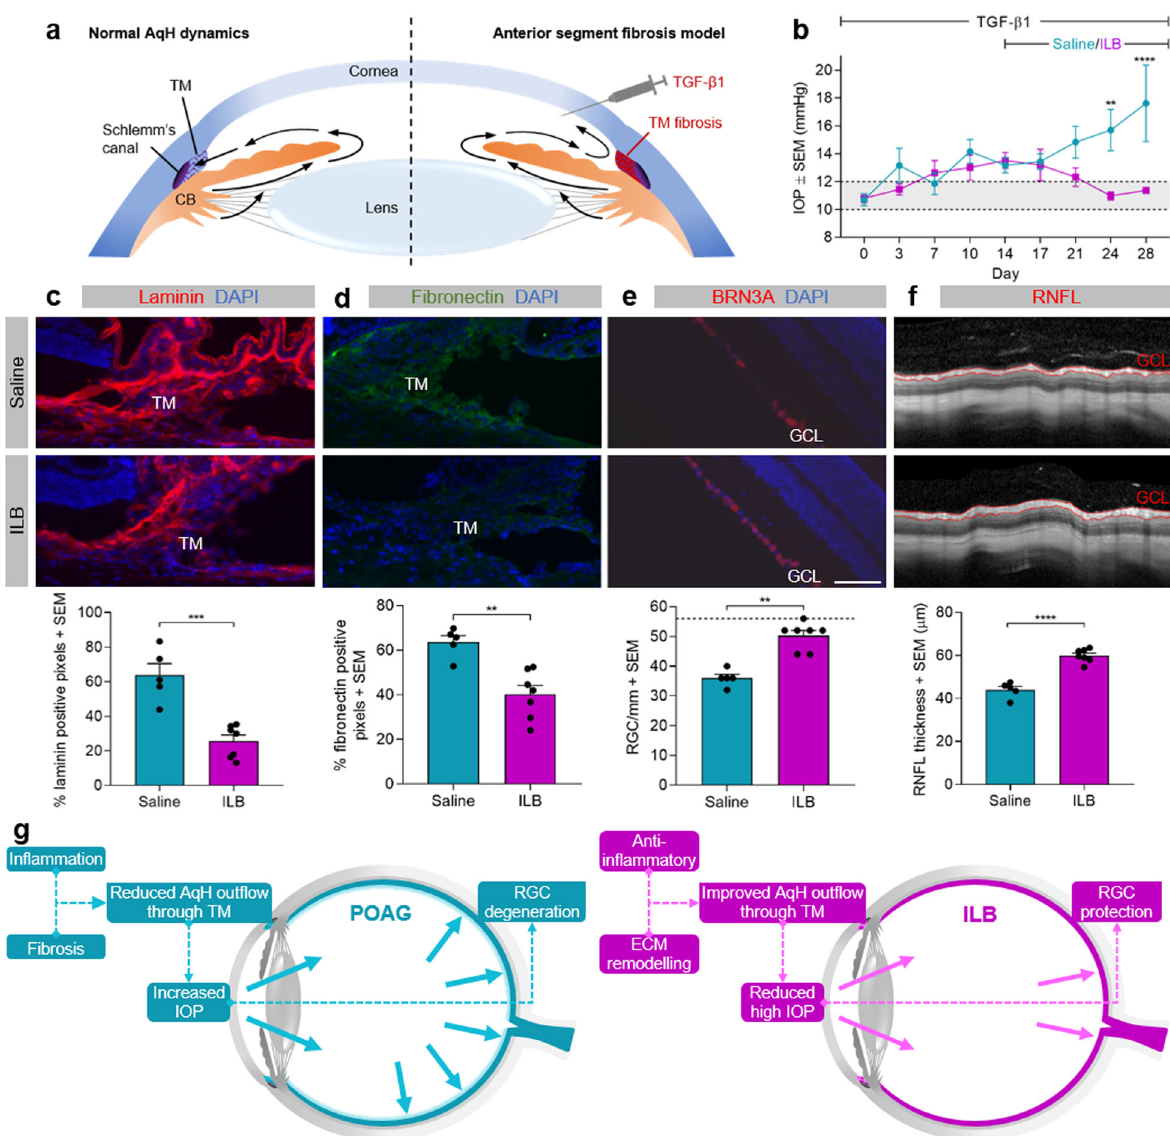
injections of TGF β 1 induced fi brosis in the trabecular meshwork (TM), blocking AqH out fl ow and raising IOP. ( b ) Line graph showing IOP measurements during IC TGF β 1 treatment for the fi rst 14 days followed by IC TGF β 1 with daily subcutaneous saline vehicle control or ILB ® treatment for a further 14 days. Normal IOP levels are indicated by the grey shaded area, ** P < 0.01, **** P < 0.0001 (2-way ANOVA). ( c , d ) Representative images of ocular tissue sections including the angle of the anterior segment together with related histograms showing levels of immunoreactive laminin (red) and fi bronectin (green) staining in the TM in the saline and ILB ® treatment groups, ** P < 0.01 *** P < 0.001 (t- test). ( e ) Representative images and histogram showing the RGC marker BRN3a (red, arrows) in retinal sections from the saline and ILB ® treatment groups, ** P < 0.01 (Mann – Whitney test), GCL — ganglion cell layer. Scale bar = 100 µm. ( f ) Representative optical coherence tomography images and related histogram showing the segmented RNFL (red outline) in the saline and ILB ® treatment groups, **** P < 0.0001 (t-test). Saline group n = 5, ILB ® group n = 7. ( g ) Schematic diagram showing the potential mechanism of ILB ® in POAG. The IOP data are described in the ILB ® patent 33